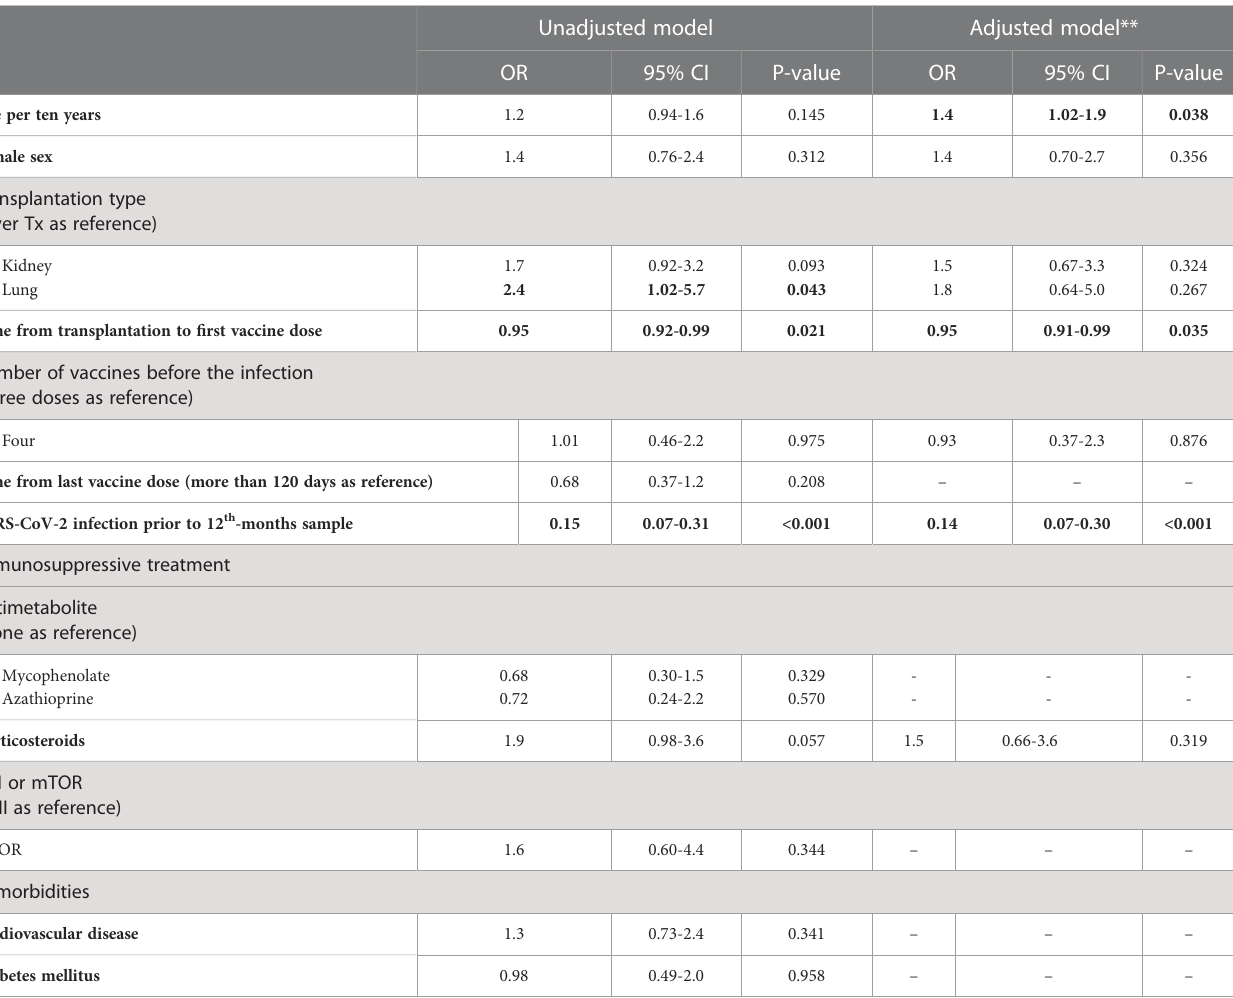
TABLE 3 Risk factors for anti-RBD IgA non